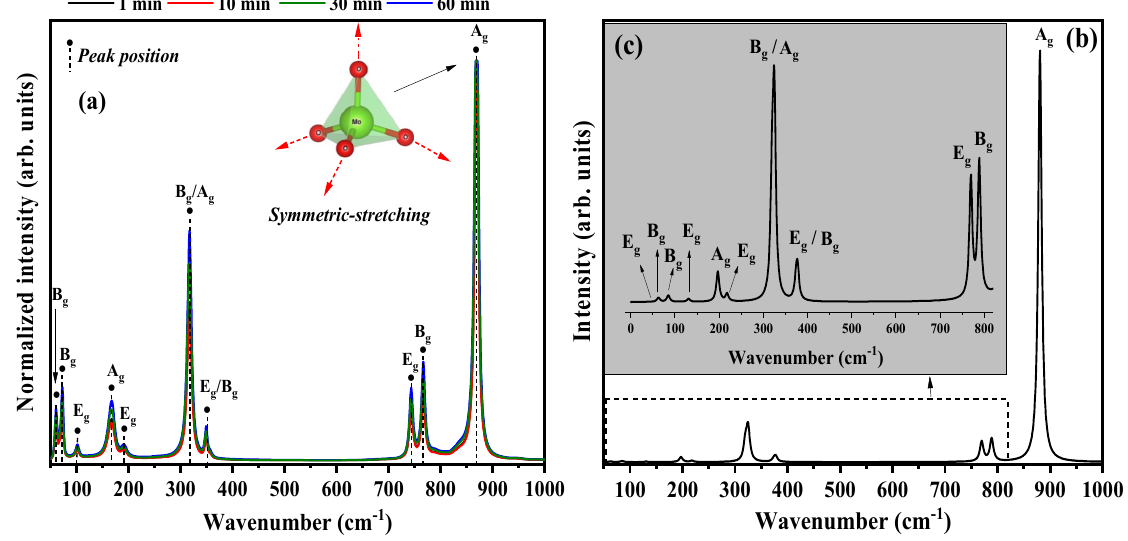
Figure 4. Raman spectra of the PbMoO 4 nanocrystals prepared by ( a ) MH method at different times (1, 10, 30 and 60 min) at 100 °C. ( b , c ) Raman spectra obtained from the theoretical study by DFT (B3LYP). The vertical lines indicate the peak positions of the Raman active modes.